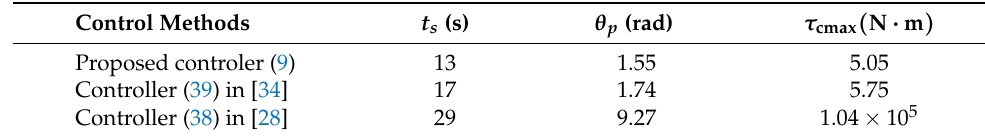
Figure 2. Time response curves of the cart position x . ( a ) Proposed method; ( b ) Method in [34]; ( c ) Method in [28]. Table 1. Quantified indexes of comparison results.